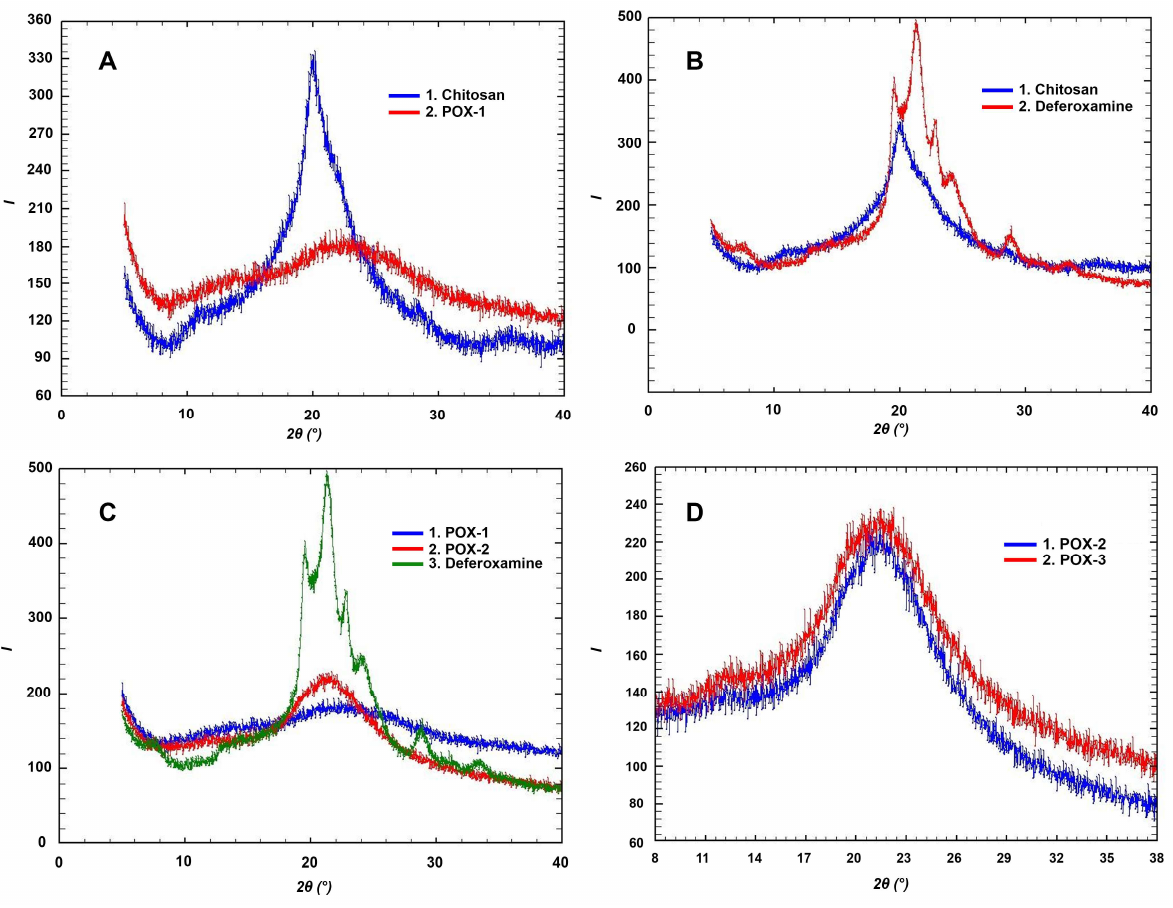
Figure 3. XRD pa(cid:308)erns of chitosan and POX-1 ( A ); XRD pa(cid:308)erns of chitosan and deferoxamine Figure 3. XRD patterns of chitosan and POX-1 ( A ); XRD patterns of chitosan and deferoxamine ( B ); ( B ); XRD pa(cid:308)erns of POX-1, POX-2 and deferoxamine ( C ); XRD pa(cid:308)erns of POX-2 and POX-3 ( D ).